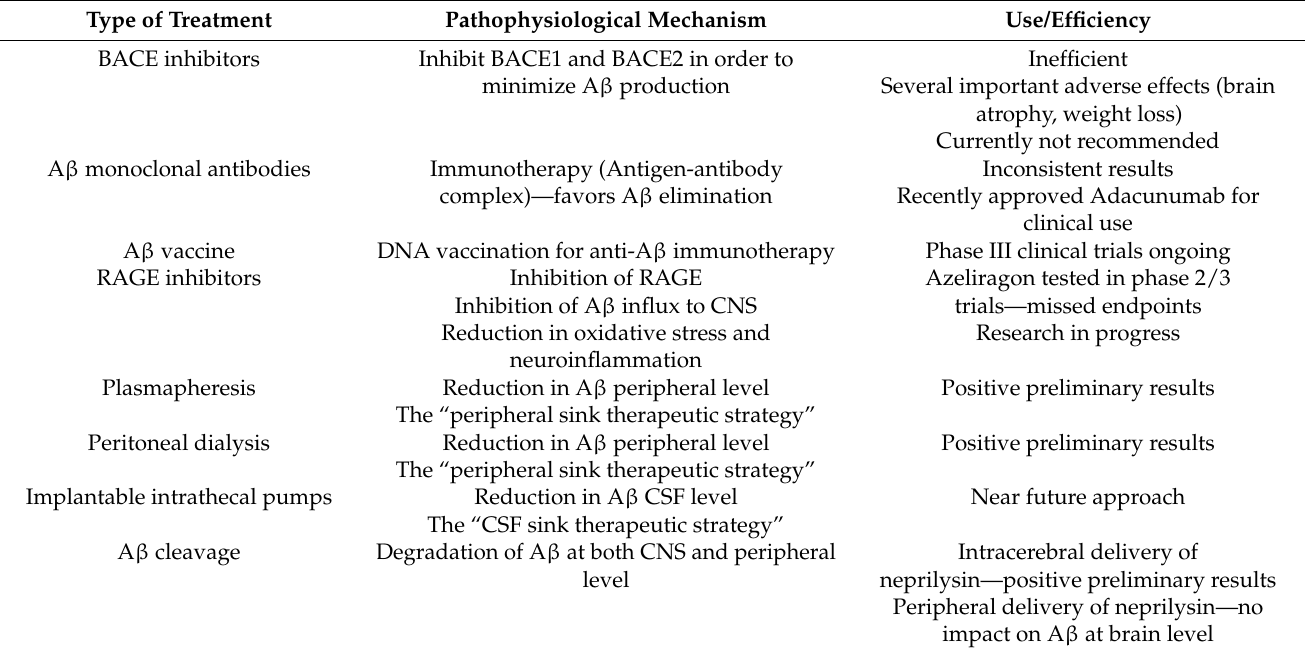
Table 2. Alzheimer’s disease—therapies with focus on the amyloidogenic